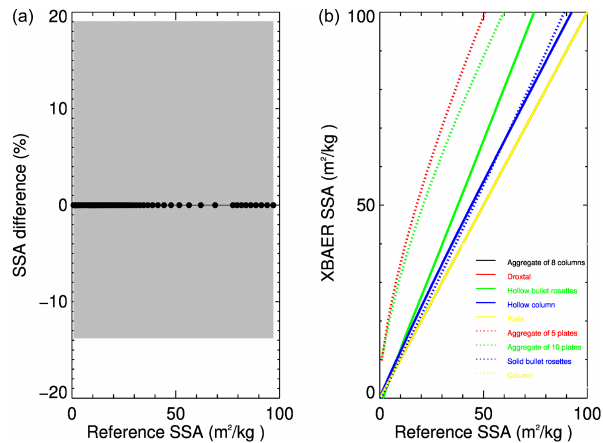
Figure 6. Impact of SPS on the retrieval of SGS. Figure 7. Impact of SGS and SPS on the retrieval of SSA. (a) SGS